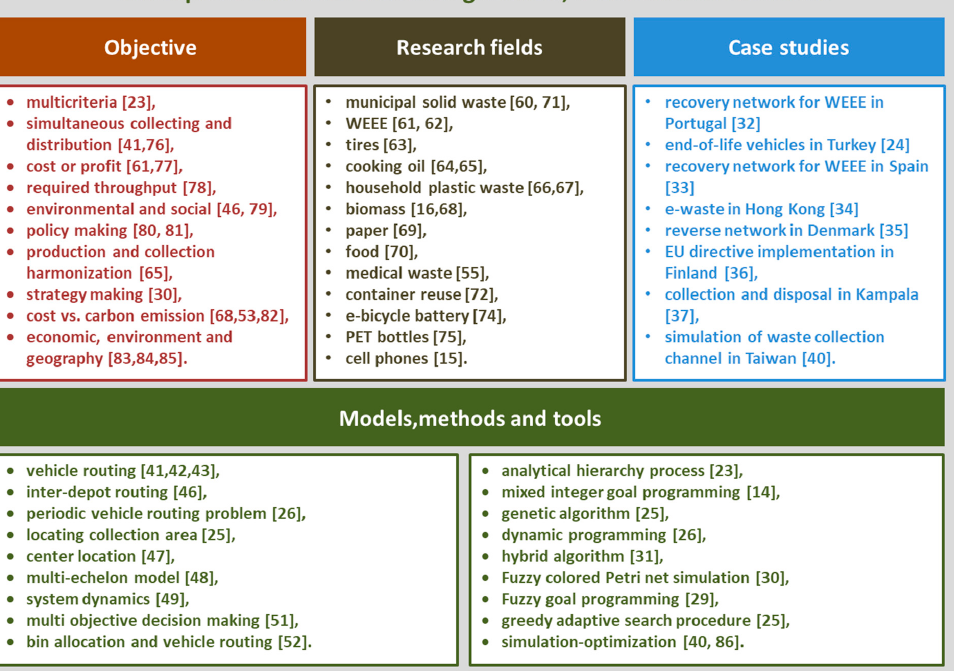
Figure 8. Conceptual framework of published articles [23–86].